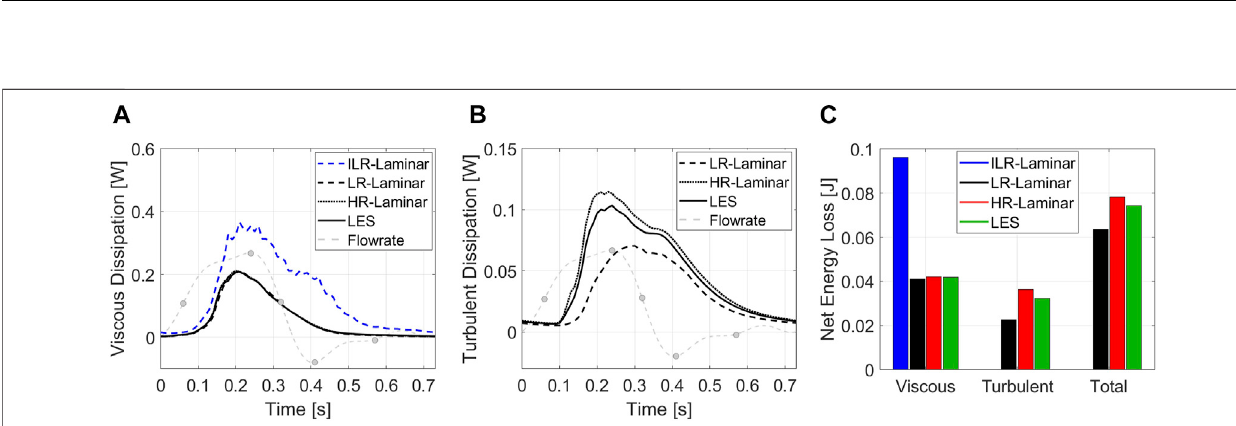
FIGURE12|(A) Viscousdissipationand (B) turbulentdissipationspatiallyaveragedovertheentireaorta,plottedoverthecardiaccycle. (C) Netenergylosses.Key times throughout the cardiac cycle are highlighted and refer to maximum acceleration, peak systole, maximum deceleration, end systole and